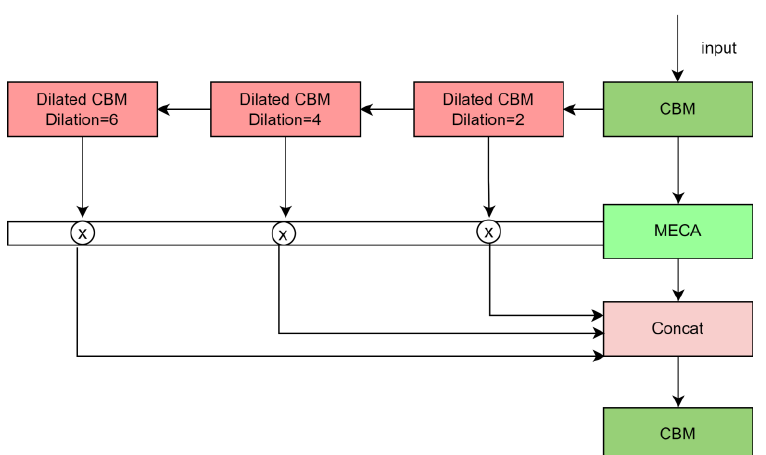
Figure 4. ASPF module, one branch passes through three series of dilate convolutions with dilate rates of 2, 4, and 6, one branch passes through the MECA attention module, and finally, the outputs of the two branches are stitched